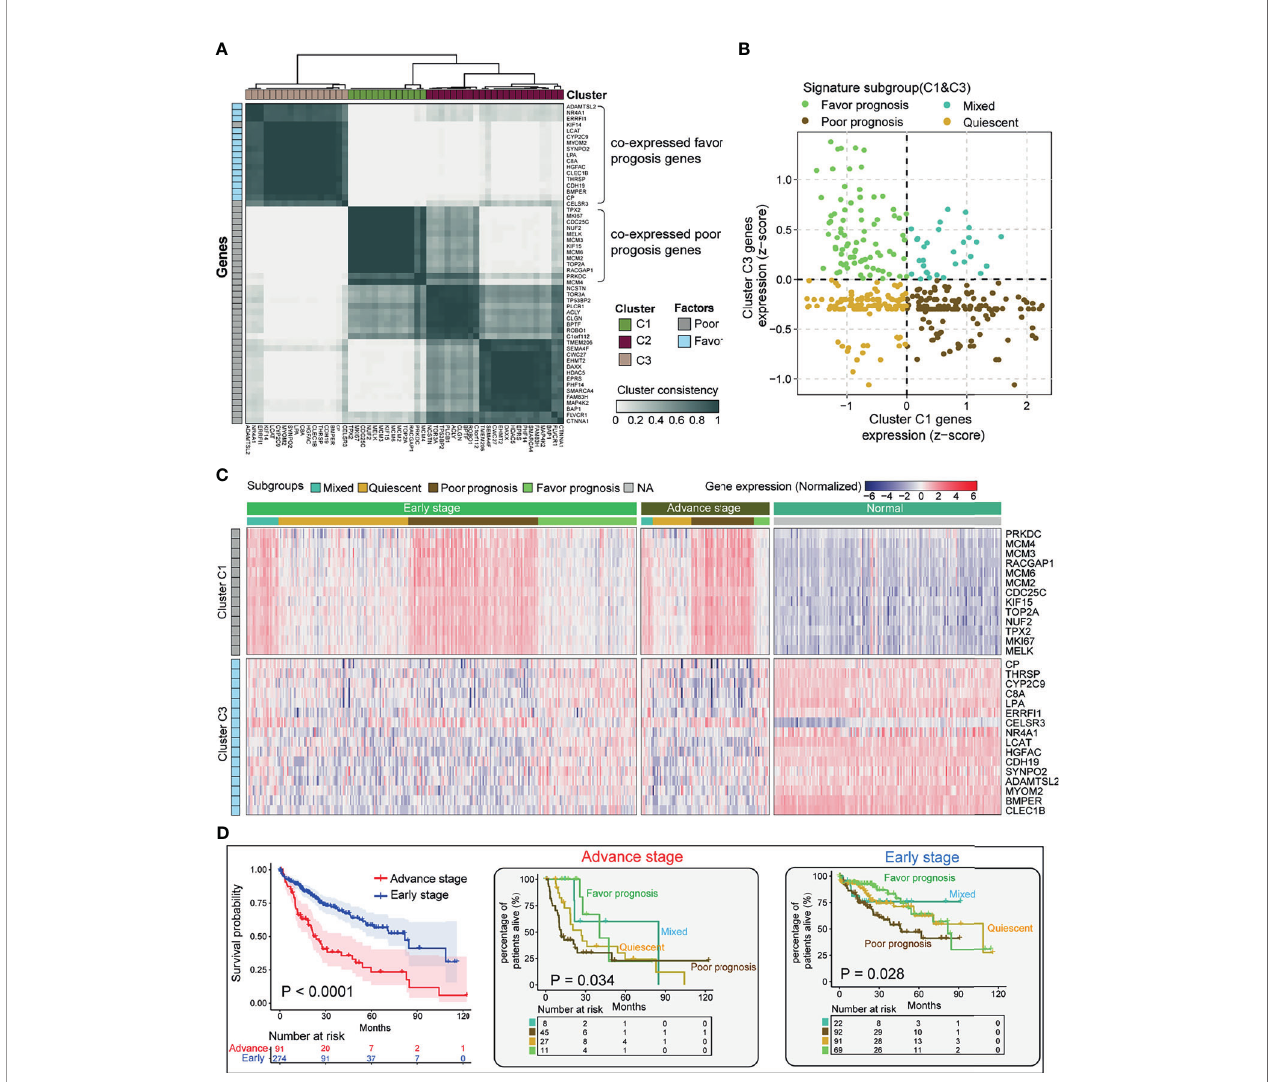
FIGURE 3 | Strati fi cation of HCC tumors based on signi fi cant prognostic DEGs. (A) Heatmap depicting consensus clustering solution (k = 3) for signi fi cant prognostic DEGs (poor/favorable) in the advanced and early diagnostic HCC patients (n = 365). (B) Scatter plot showing median expression levels of Cluster C1 (x-axis) gene and Cluster C3 gene (y-axis) in each HCC patient. Signature subgroups were assigned based on the relative expression levels of selected Cluster genes. (C) Heatmap depicting expression levels of Cluster C1 and Cluster C3 genes across each subgroup in different pathological stages. (D) Kaplan – Meier survival analysis of early-stage and advanced-stage HCC patients (left). Multiple survival curve analysis of advanced-stage (med) and early-stage (right) HCC divided by signature subgroup Cluster C1. Log-rank test p -values are shown. HCC, hepatocellular carcinoma; DEG, differentially expressed gene.